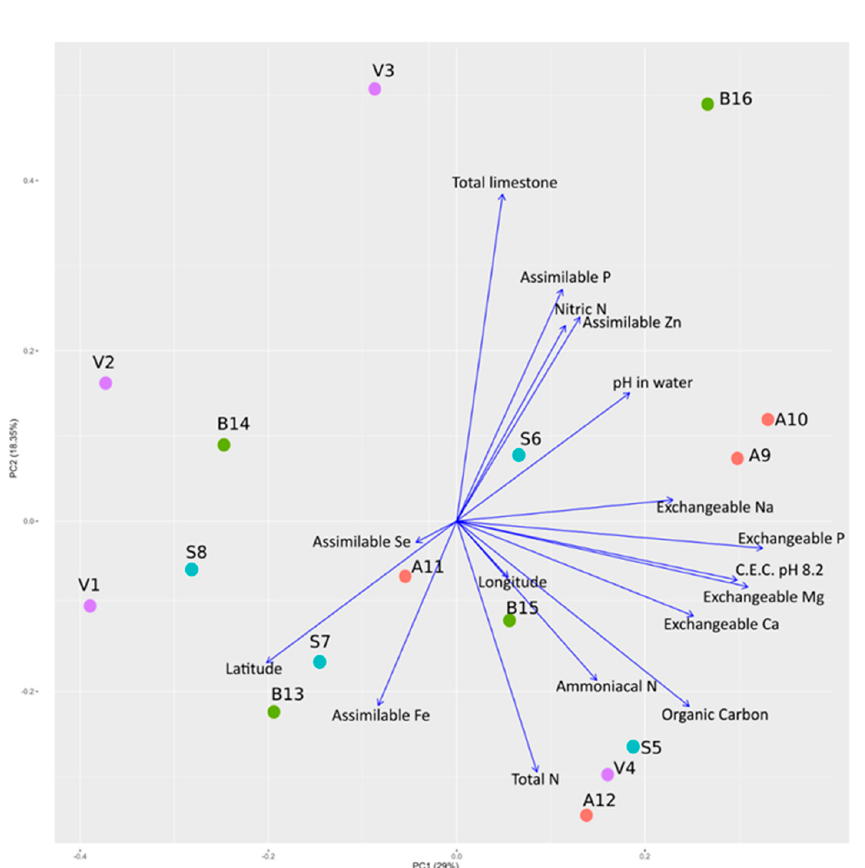
Figure 1. Influence of physicochemical composition and geographical coordinates of soil samples with respect to the sowed varieties. A Principal Component Analysis of physicochemical composition and geographical coordinates of soil samples is reported with a biplot showing the percentage of variance of the first two components. Codes of samples are as in Table 1.